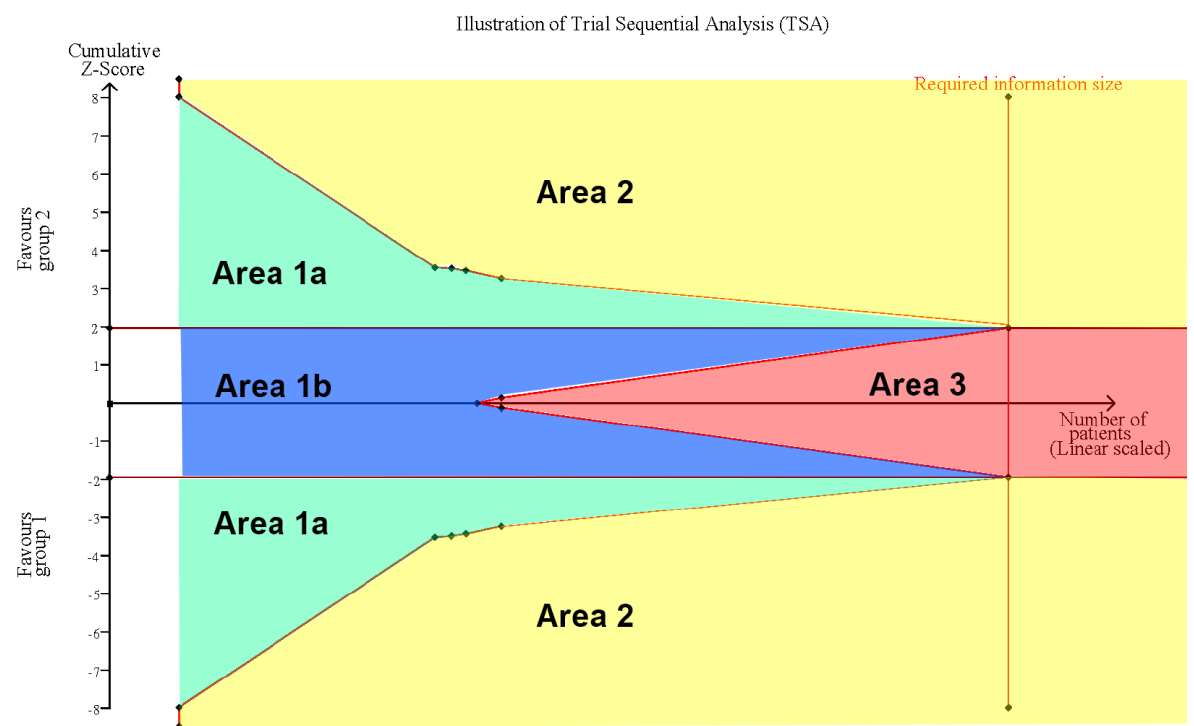
Figure 1. Illustration of Trial Sequential Analysis (TSA). Area 1 between sequential monitoring boundary and inner wedge indicated the inconclusive result which may suffer from false positive (Area 1a) or false negative (Area 1b), more sample size is required for further consolidate conclusion. Area 2 demonstrate conclusive result of significant effect of experimental group or control group, while Area 3 indicate the conclusive result of non-significance between experimental group and control